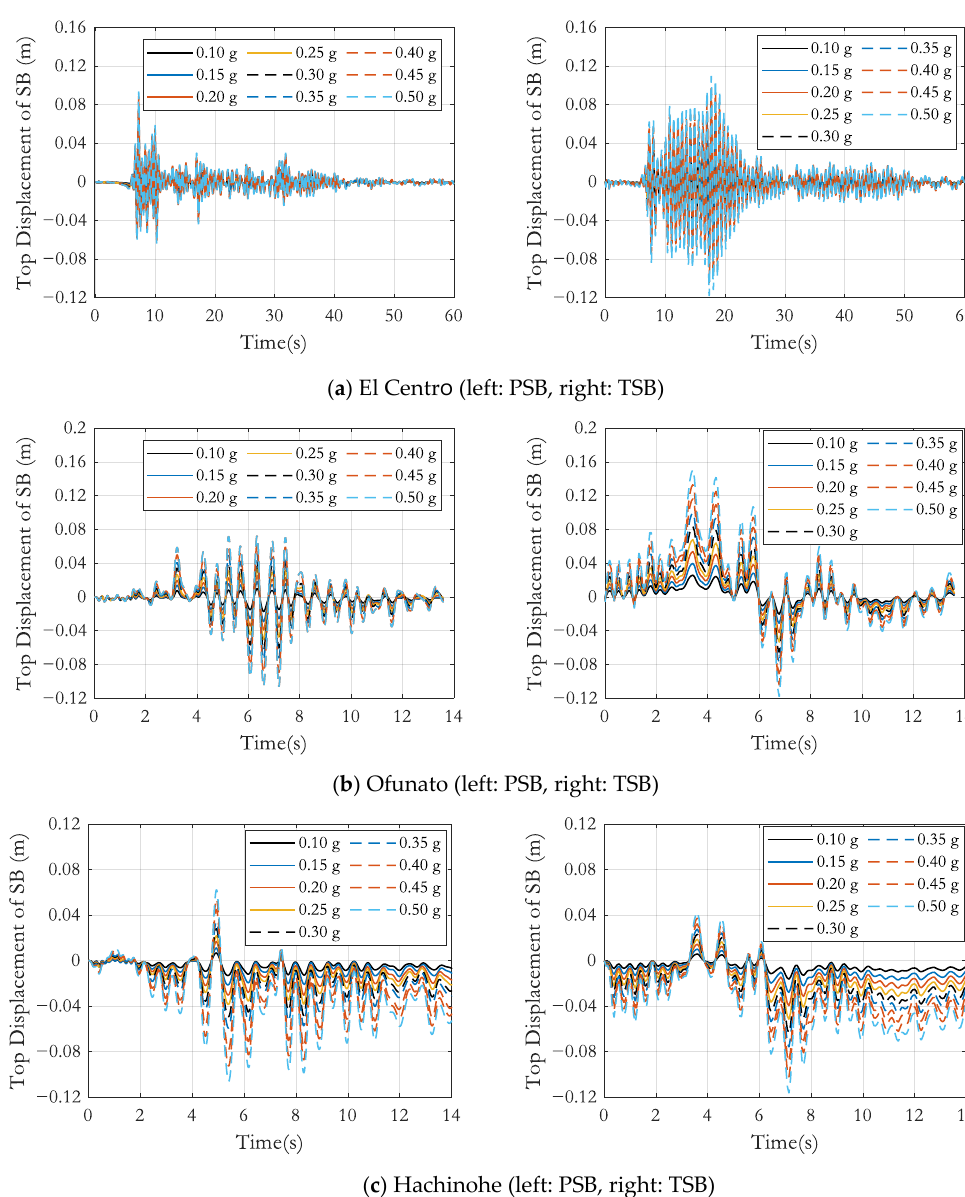
Figure 17. Top displacement of SB under earthquake motion.